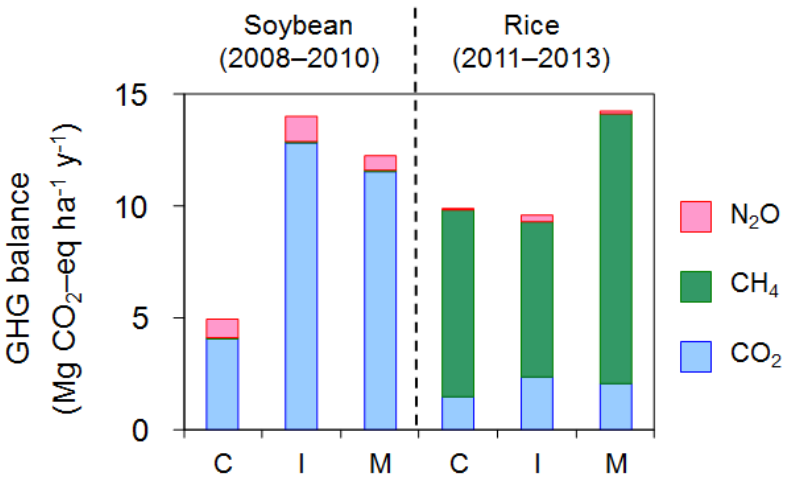
Figure 5. Comparison of net greenhouse gas (GHG) balance in soybean (upland) and rice (paddy) cultivation field. Positive values indicate net emission to the atmosphere. Carbon dioxide (CO 2 ) was estimated from soil carbon loss. Methane (CH 4 ) and nitrous oxide (N 2 O) fluxes were obtained by the closed chamber method. C: control; I: immature compost; M: mature compost.